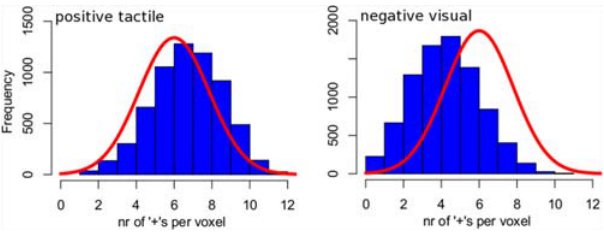
Figure 5. Histogram distributions of voxels that are part of active fibers. Here two histograms are shown of the number of ‘ + ’s per voxel, for all voxels along active fiber tracts, separately for positive correlation and negative correlation, combined for all subjects. In the case that there would not be an activity-related signal change, the distribution of + ’s in these voxels would follow a normal distribution (solid red line). If only a small group of voxels (the active voxels) is responsible for a tract to be considered active then these voxels must show a high correlation (i.e. a high number of + ’s) with the task while the distribution of + ’s of the other (non-active) voxels that are part of the active tract would remain unchanged. This would result in a histogram built up from a large and a small normal distribution. The large group of non-active voxels would produce the original (large) normal distribution (solid red line) while the small group of active voxels would produce a second smaller distribution left (negative correlation) or right (positive correlation) from the original distribution. However, if not a small group but the majority of the voxels along the active fibers belong to the set of active voxels, one would expect a single normal distribution which is shifted to left (negative correlation) or to the right (positive correlation). Left, the histogram for the (positive) active voxels for the tactile task is shown while on the right side the histogram for the (negative) active voxels of the visual task is shown. Both histograms appear to follow a single normal distribution but are shifted to the right (positive correlation with tactile task) or to the left (negative correlation with visual task). This suggests that the task-related signal changes found with fDTI indeed occur along large parts of the fibers and are not confined to small parts of the fibers.